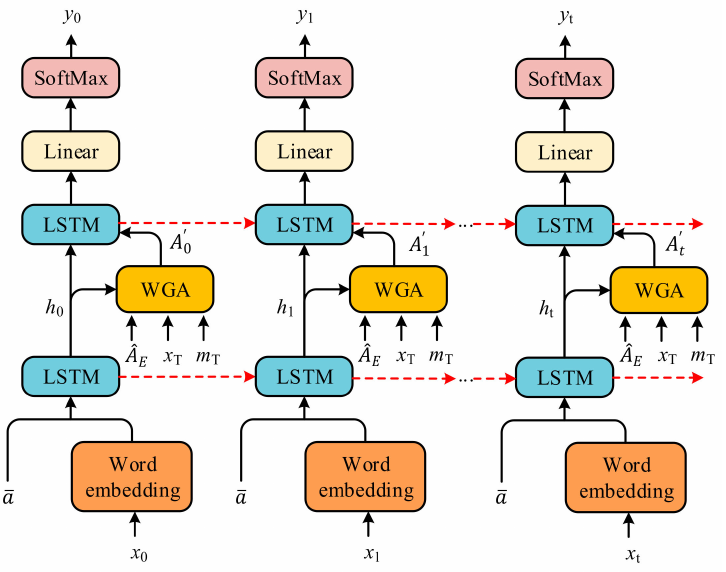
Figure 4. The framework of the decoder, which includes two LSTMs, a WGA module, and a prediction of word probability